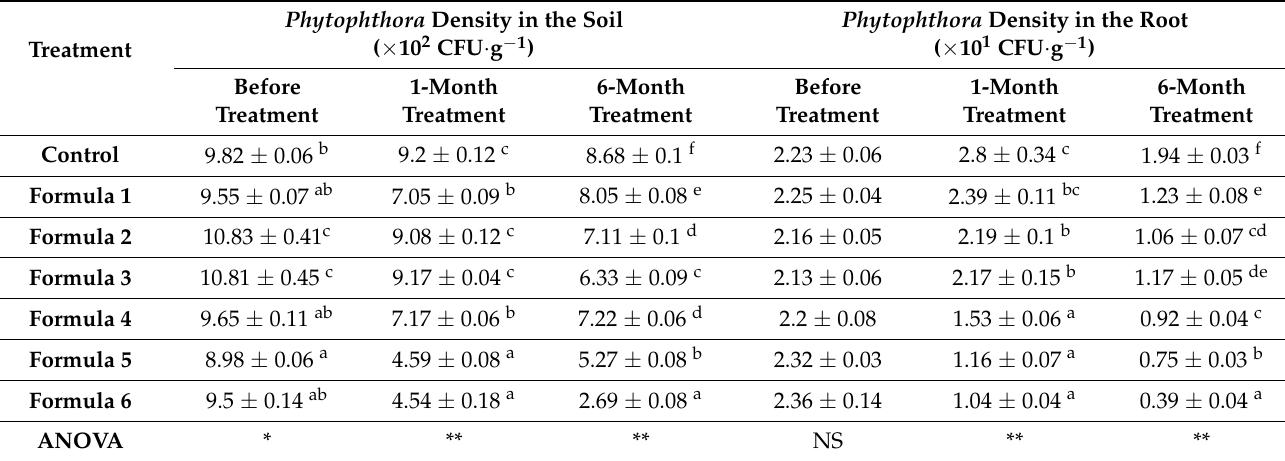
Means ± standard errors within a column followed by the same superscript letter(s) are not significantly different according to the Duncan’s multiple range test. NS: non-significant differences, * p < 0.05, ** p < 0.01.